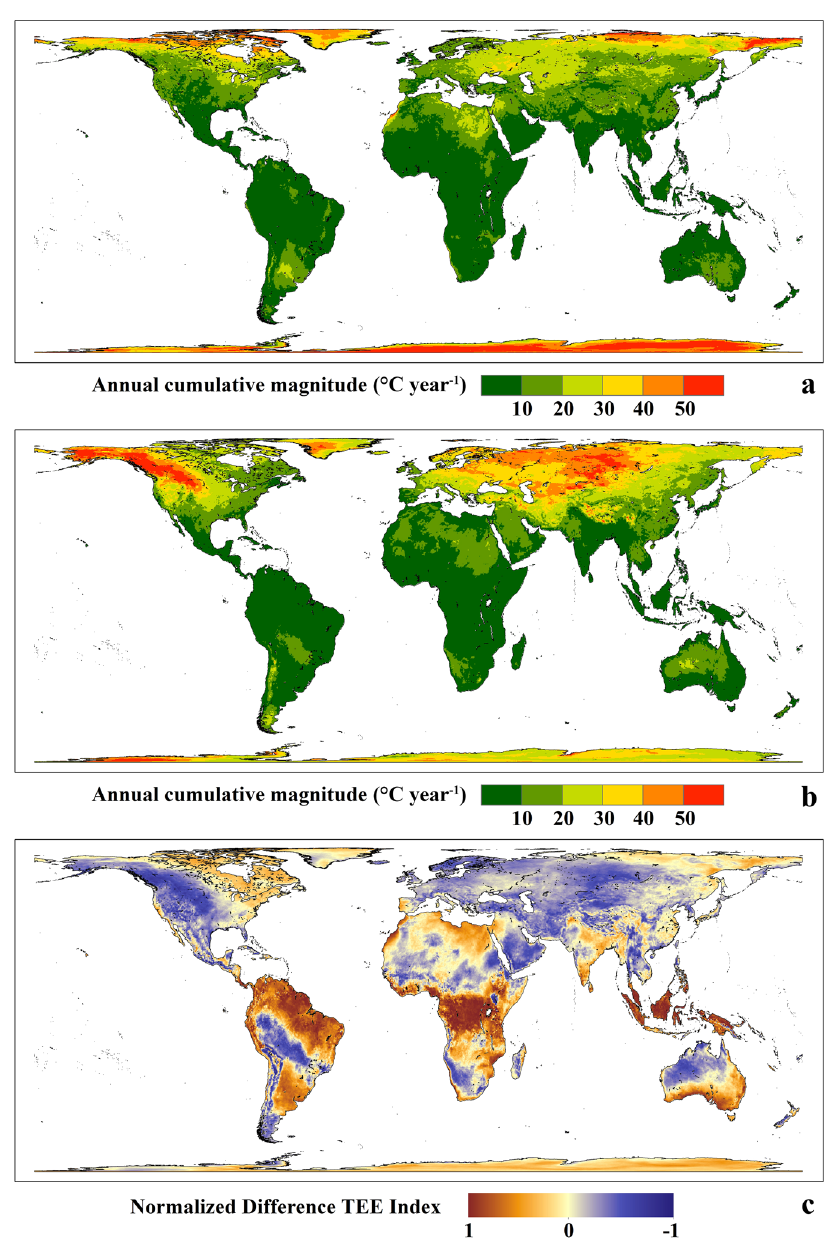
Fig. 3 Global distribution of annual cumulative magnitude ( M ) for heat and cold extremes, and of Normalized Difference TEE Index (NDTI). a M of heat extremes. b M of cold extremes. c